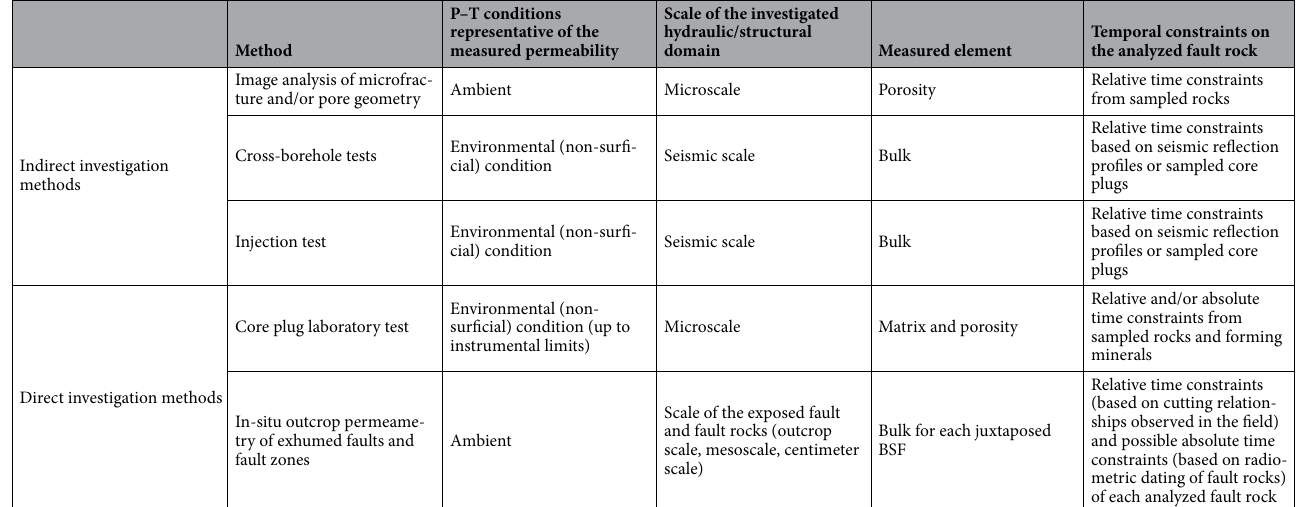
Table 1. Summary of the most adopted methods to directly/indirectly constrain fault rock permeability (summarized from 24